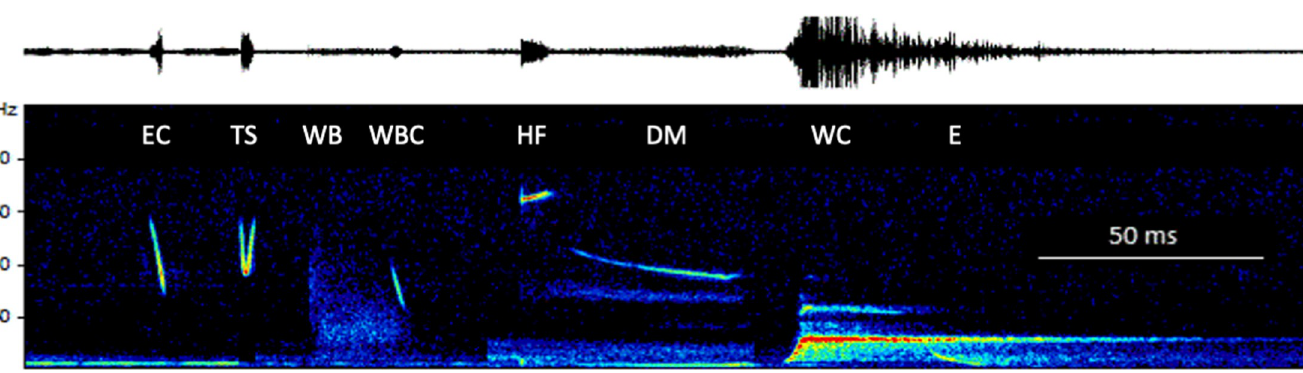
PLOS ONE | https://doi.org/10.1371/journal.pone.0241063 November11,